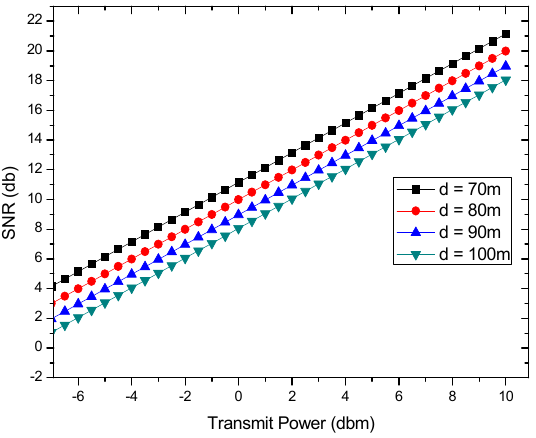
Figure 3. Signal-to-noise ratio in different transmit power with different distance.